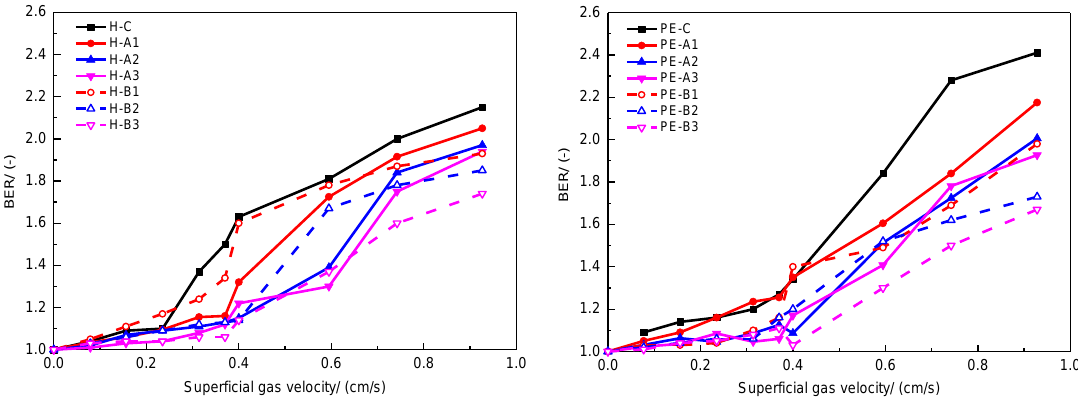
Figure 6. Bed expansion ratios (BERs) of samples respect to superficial gas velocity.